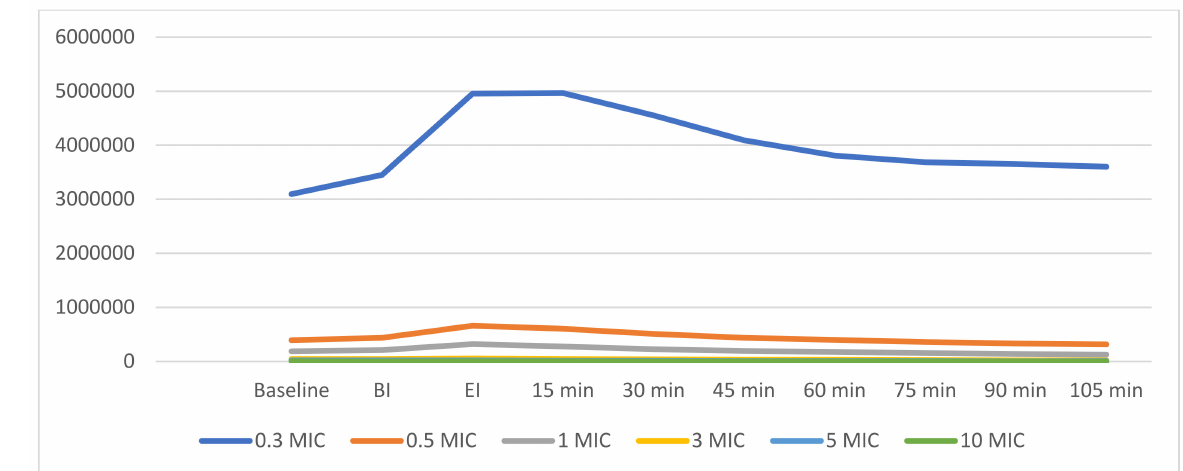
Figure 2. Linear graphs representing the dynamics of aerosols after ultrasonic scaling. Summary of aerosol dynamics of differently sized particles. MIC = abbreviation for µ m